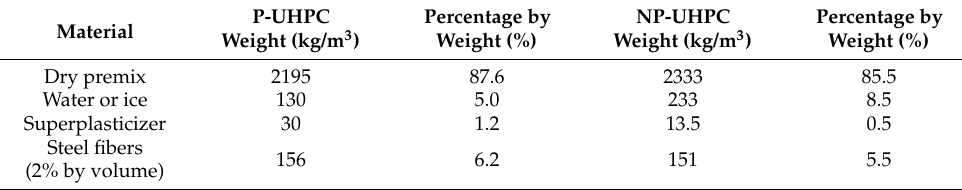
Figure 2. Experimental test results of the reference P-UHPC specimen: ( a ) Load versus mid-span deflection; ( b ) Load versus tensile strains at the middle of the bottom transverse reinforcement. Table 3. Mixing Proportions of the P-UHPC and NP-UHPC